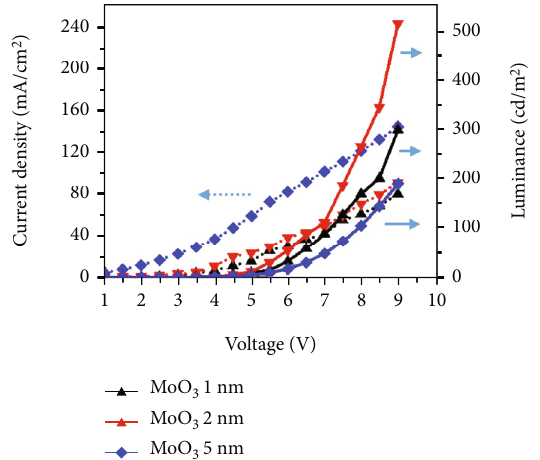
Figure 7: Current density-luminance-voltage curves of TE-OLED with the MoO thickness 3